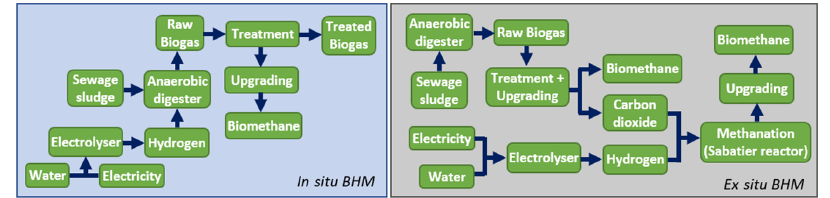
Figure 3. Biological Hydrogen Methanation diagrams (in situ and ex situ).